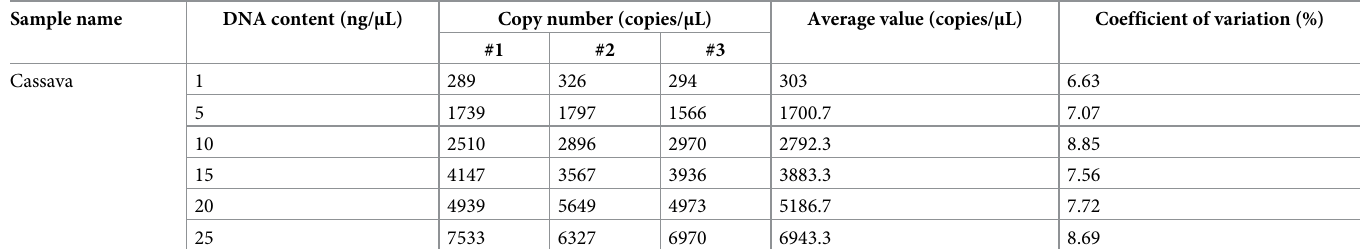
Table 4. Cassava copy number under gradient DNA content.